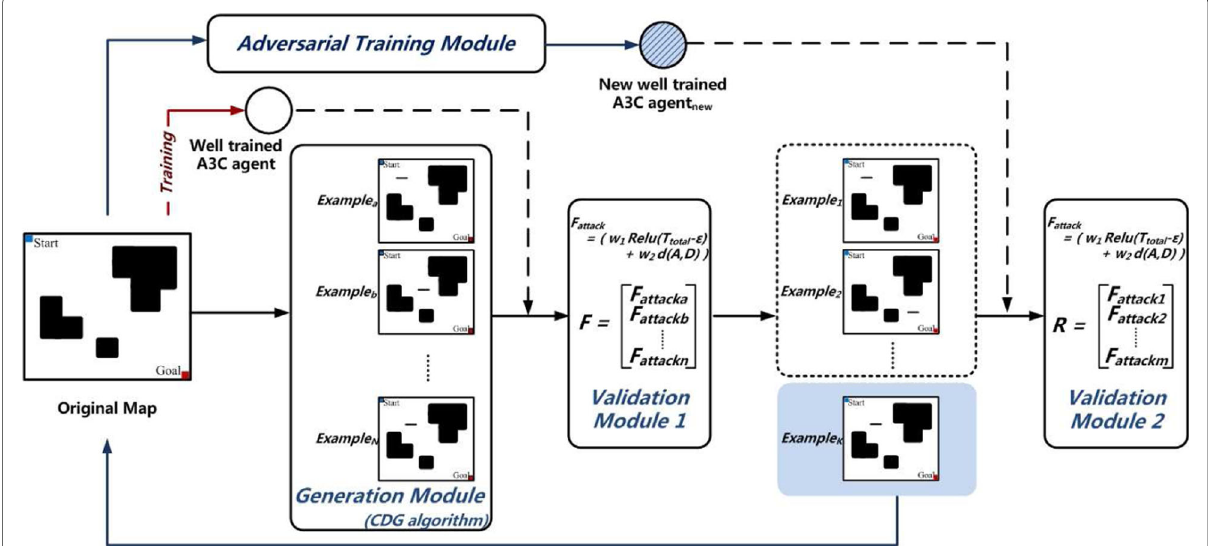
Fig. 10 Architecture for the gradient band-based generalized attack immune